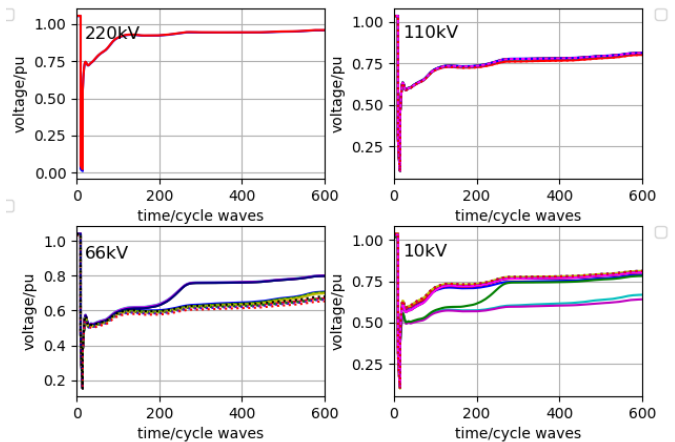
Figure 11. Fault 1 Action 19: Bus positive sequence voltages after SVG compensates 20 Mvar, 50 Mvar, 70 Mvar, 50 Mvar and 70 Mvar, respectively.